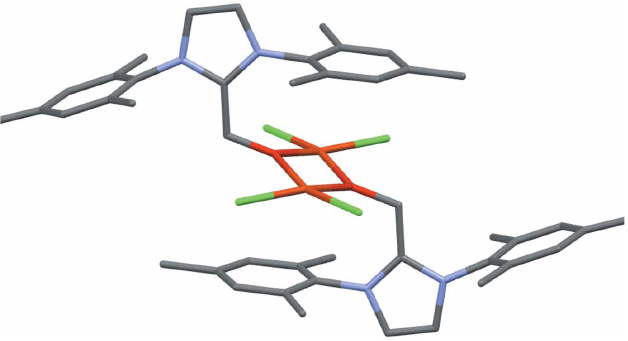
Figure 2 Molecular structure of dimeric (I). The two halves of the dimer are related by (cid:5) x , (cid:5) y + 1, (cid:5) z + 2. H atoms are omitted for